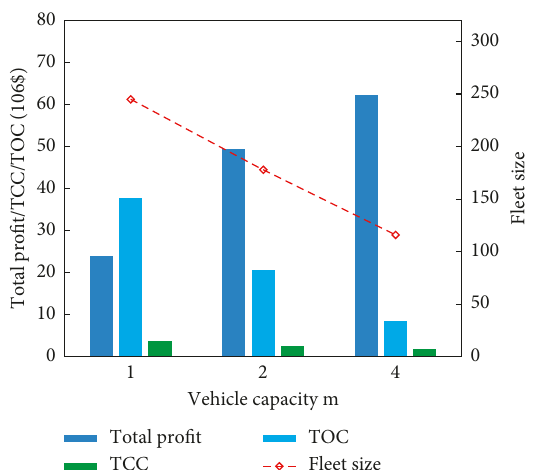
Figure 11: Impact of ride-pooling on system performance.